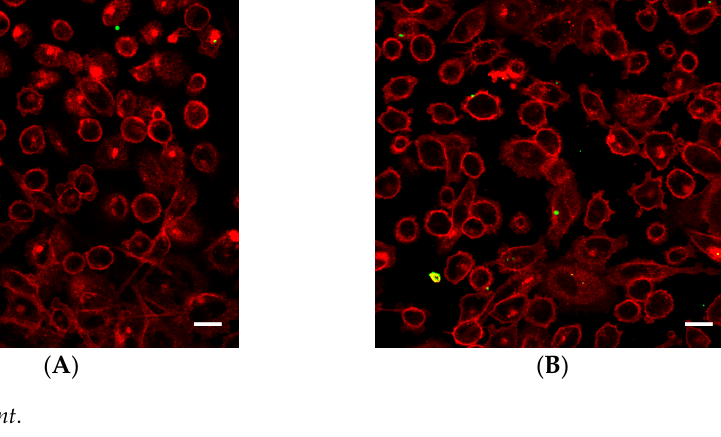
Figure 3. ( A ): Scanning electron microscopy image of a nanoparticle-loaded microbubble, demon- strating the morphology of the shell; the scale bar is 5 µm . Image reprinted with permission from [39]. ( B ) Confocal microscopy image of microbubbles to visualize nanoparticle loading by fluorescence (green); the scale bar is 10 µm . ( C ): Representative size distribution of the microbubbles.